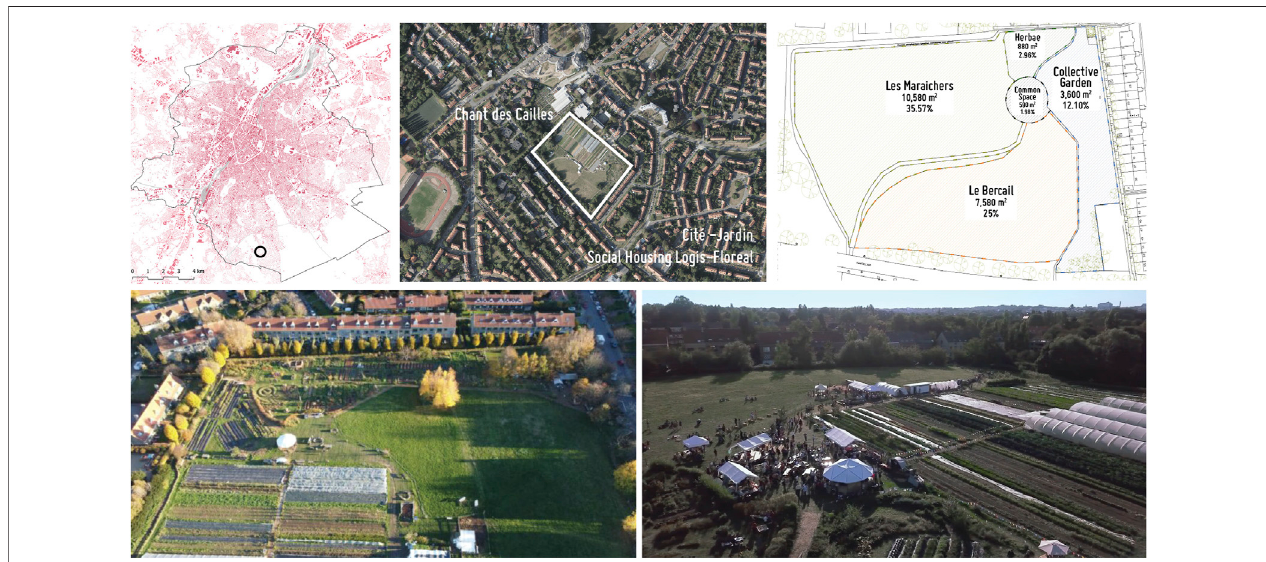
FIGURE 4 | Location in the BCR, aerial view from Google Maps, plan, and photos from the website “ Ferme du Chant des Cailles ” (consulted in June 2021). By the authors.